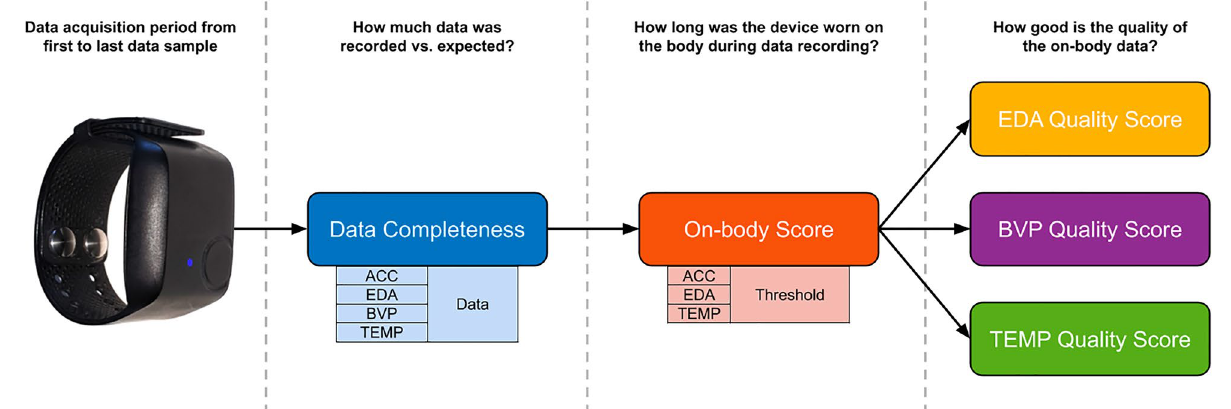
Figure 1. Data quality assessment pipeline. The amount of data referenced in each step decreases from left to right, that is, the data completeness score is relative to the whole recording period, whereas the individual signal quality scores are relative to the amount of data that was estimated as